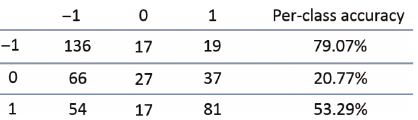
Figure 23: Testing Confusion Matrix of Experiment 1.